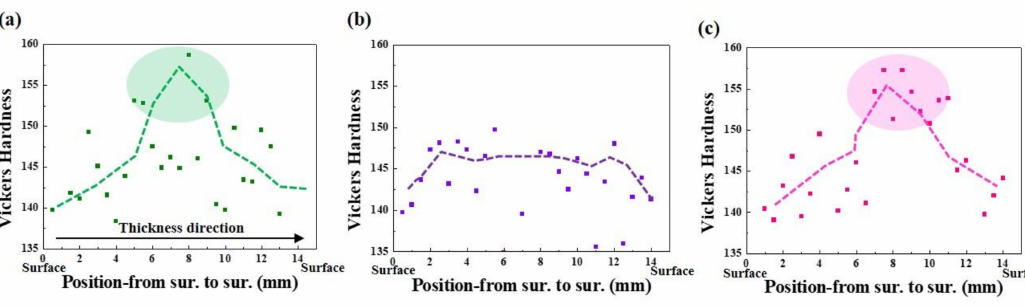
Figure 3. HIC test results obtained by ultrasonic detection: ( a ) Steel A, ( b ) Steel B, ( c ) Steel C, and ( d ) CAR values of the three samples.